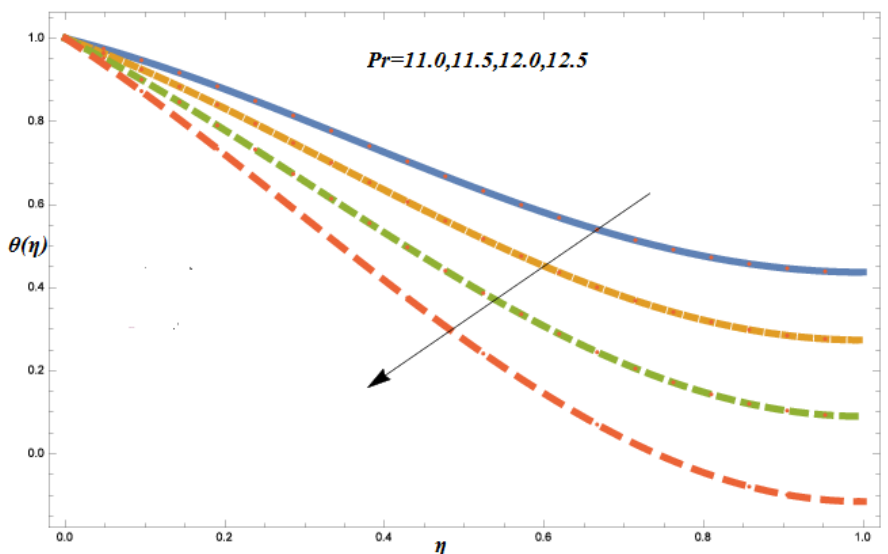
Figure 11. The variation of temperature scale gradient θ ( η ) for different values of P r , when (cid:125) = − 0.25, S = 0.7, B r = 0.7, N r = 0.7, D u = 0.7, S c = 0.7, ε = 0.7, S r = 0.7, λ = 0.7, Λ = 0.7, β = 1.